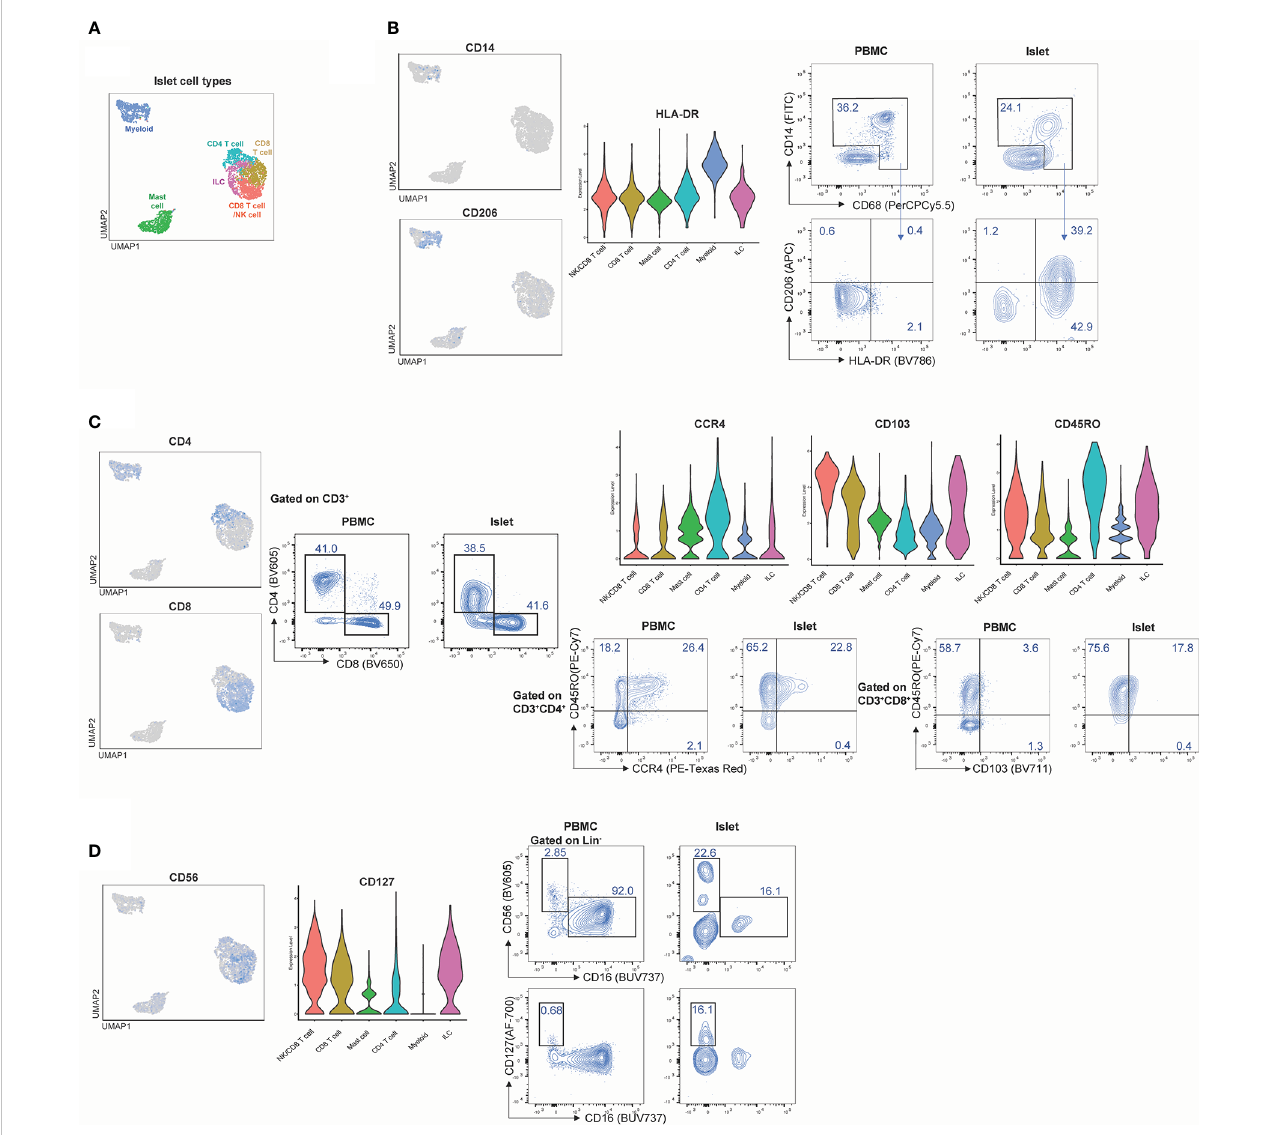
FIGURE 7 CITE-Seq protein expression is validated by fl ow cytometry on healthy human islets. Healthy human islets were analyzed by CITE-seq and fl ow cytometry. Surface marker proteins found to be expressed by islet-resident immune cells by CITE-seq were analyzed by fl ow cytometry in order to validate CITE-seq fi ndings. PBMCs were used a staining control for fl ow cytometry analysis. (A) human islet UMAP, (B) Myeloid population analysis of CD14, CD206 and HLA-DR expression. (C) T cell population analysis of CD4, CD8, CD45Ro, CCR4 and CD103. (D) ILC analysis of CD56 and